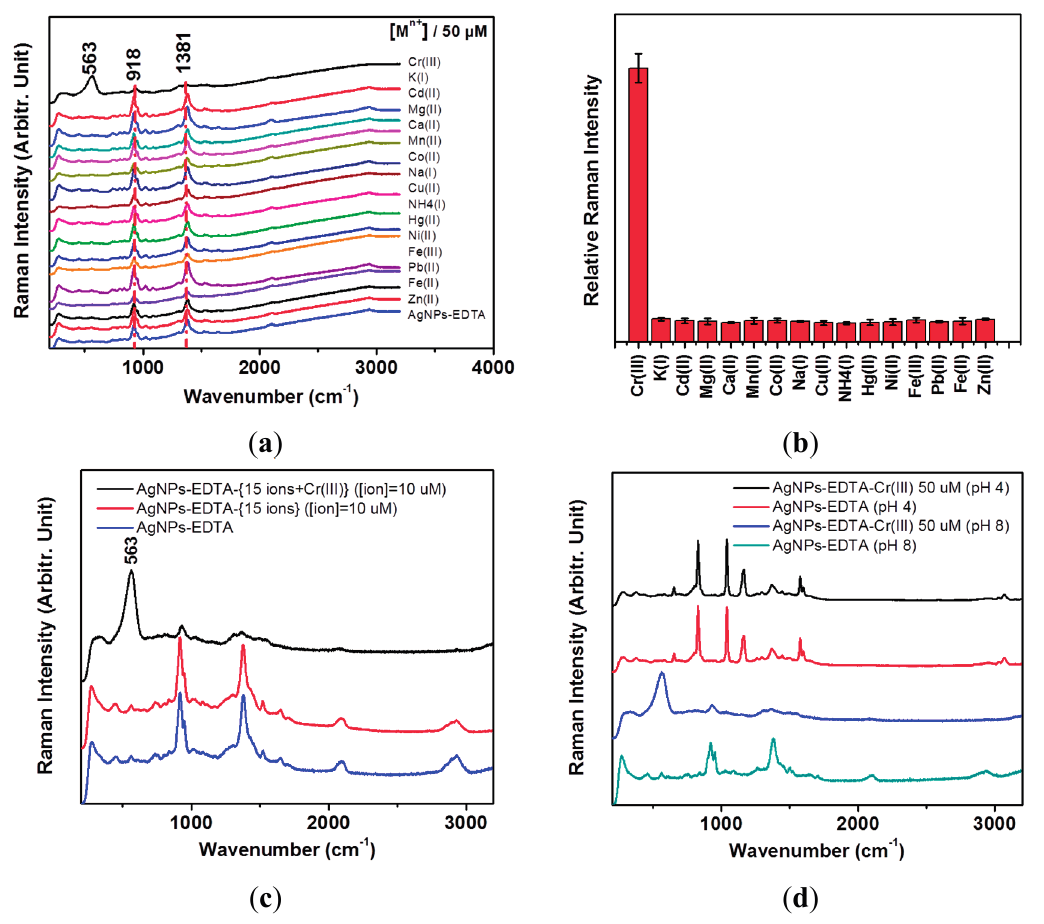
Figure 3. ( a ) Surface-enhanced Raman spectroscopy (SERS) spectra of detection of Cr(III) using Tris(hydroxymethyl)aminomethane (Tris)-EDTA on AgNPs. Selective tests were performed for 50 μ M of Cr 3+ , K + , Cd 2+ , Mg 2+ , Ca 2+ , Mn 2+ , Co 2+ , Na + , Cu 2+ , NH 4+ , Hg 2+ , Ni 2+ , Fe 3+ , Pb 2+ , Fe 2+ , and Zn 2+ ions; ( b ) Stick diagram of the intensities at ~563 cm − 1 with respect to those at ~918 cm − 1 versus 16 ionic species; ( c ) SERS spectra of the mixture of the 15 ions to test the competitive reactions; ( d ) Comparative SERS spectra of EDTA and EDTA-Cr 3+ on AgNPs at pH 4.0 and pH